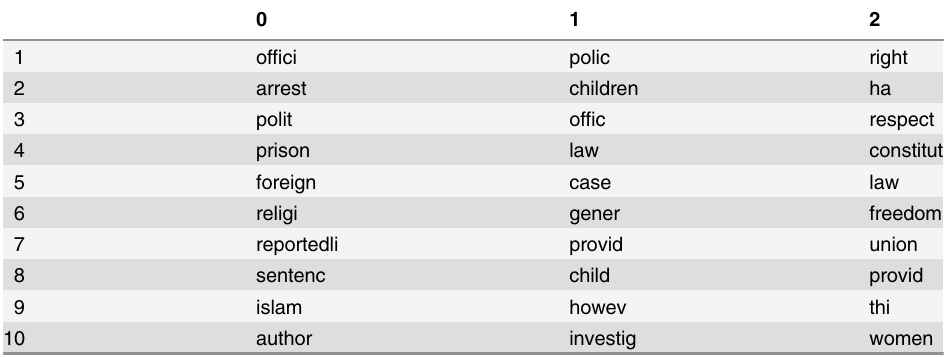
Table 11. Ten most important words for the CIRI Worker Rights variable.